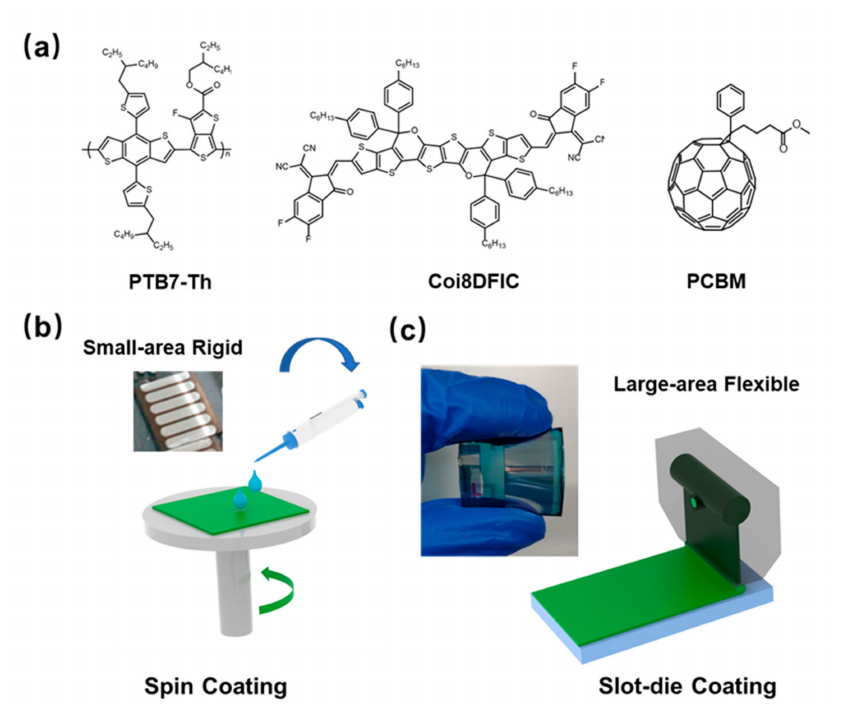
Figure 1. ( a ) Chemical structures of PTB7-Th, PC 61 BM and COi8DFIC. ( b ) Schematic of spin-coated and small-area rigid devices. ( c ) slot-die process and large area flexible devices and large area flexible devices.